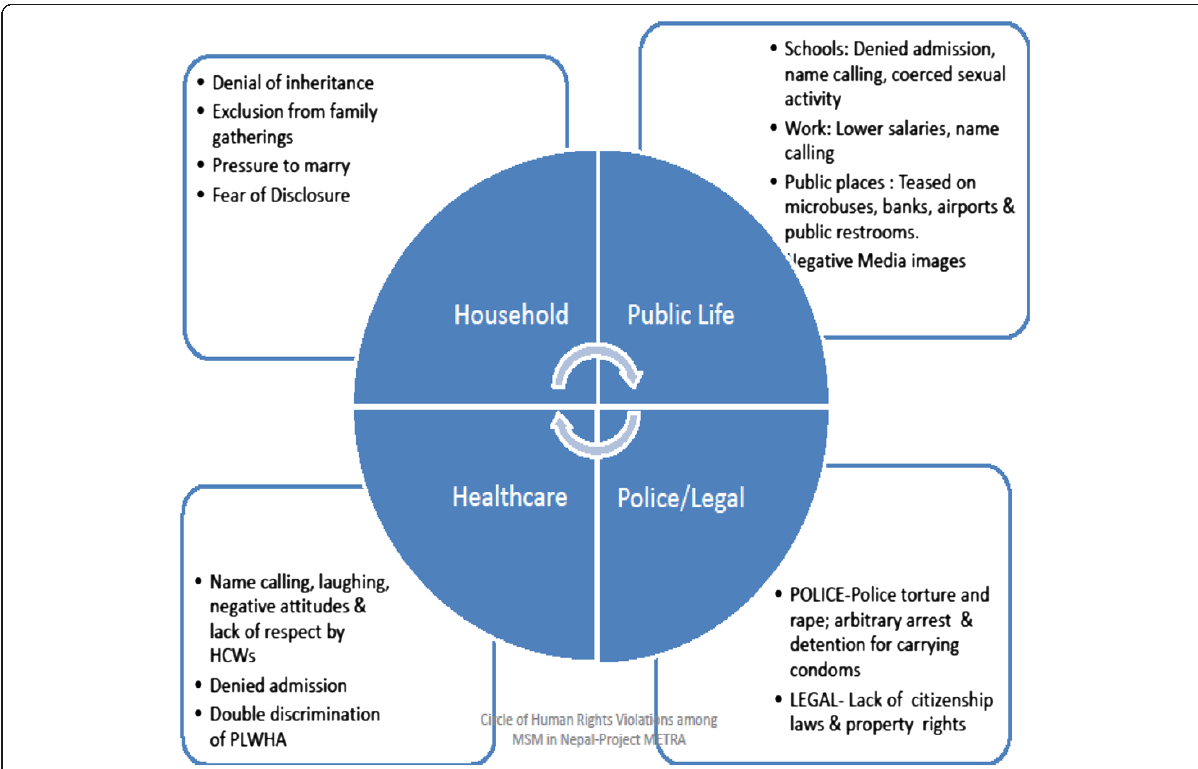
Figure 1 Circle of Human Rights Violations among Sexual and Gender Minorities in Nepal. PLWHA=People Living with HIV